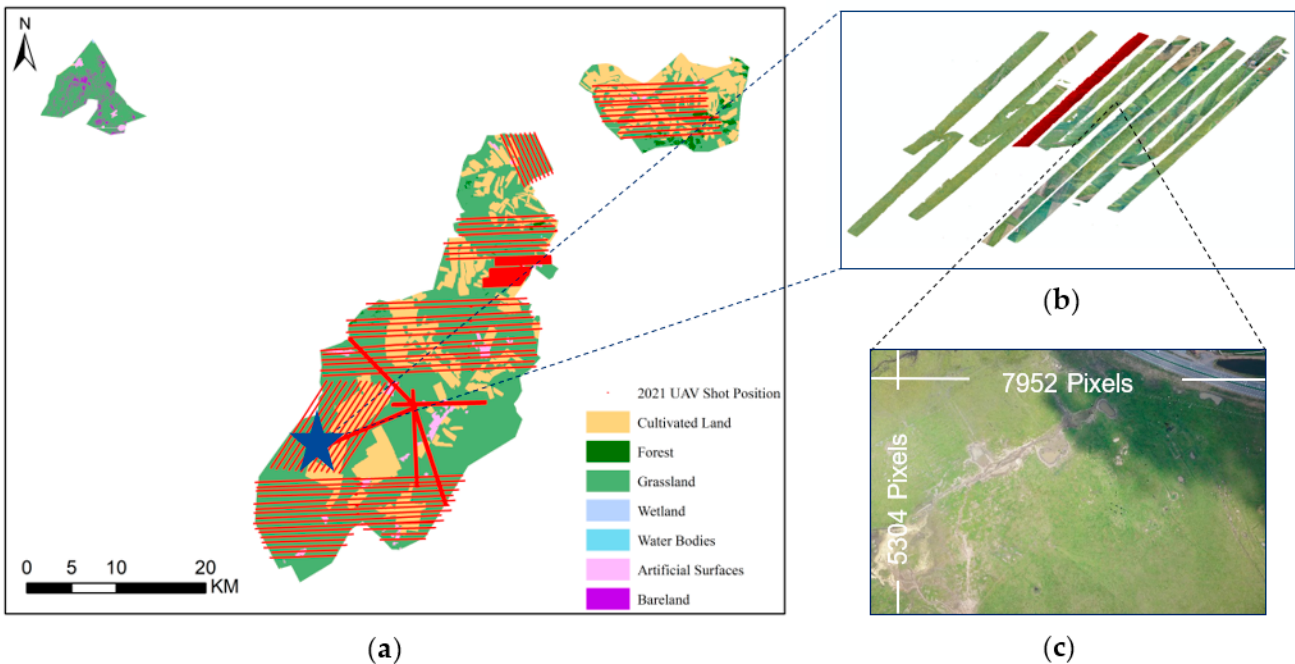
Figure 1. Data collection. ( a ) Map of Hadatu Pasture and UAV flight routes; ( b ) flight strip image captured and mosaiced by the UAV; ( c ) original image sample of the UAV.